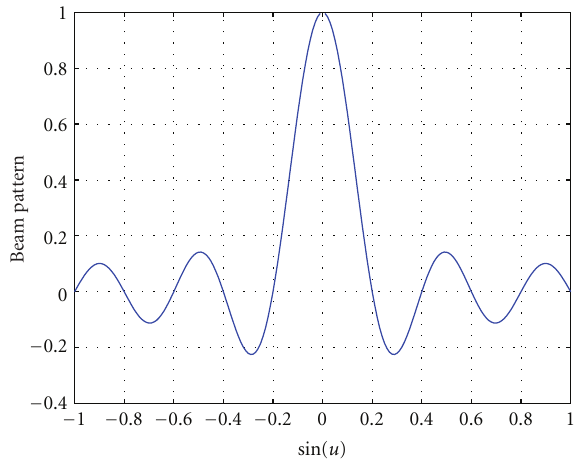
Figure 1: Beam pattern of the uniform linear array ( M = 10, d/λ = 0 . 5, u 0 =